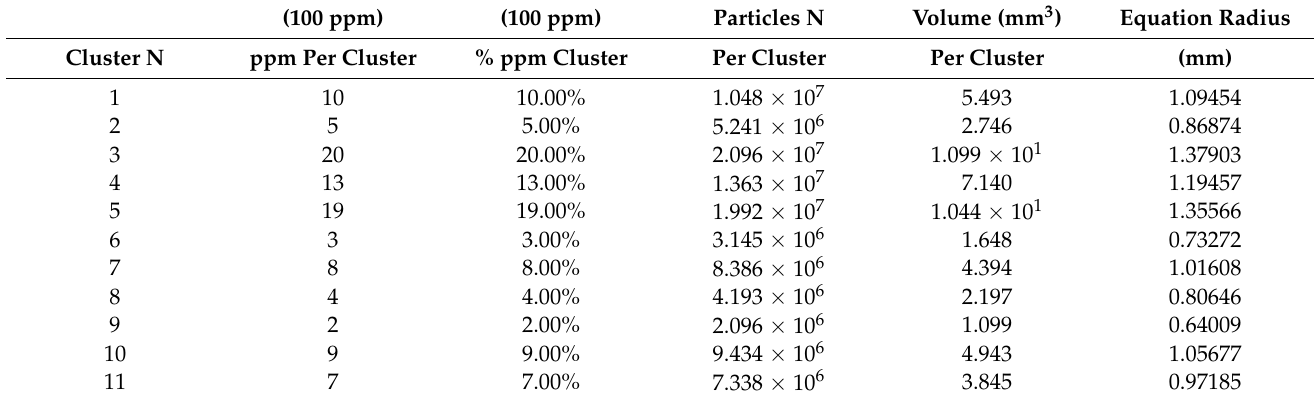
Table 7. Cluster configuration—100 ppm PO4 group.